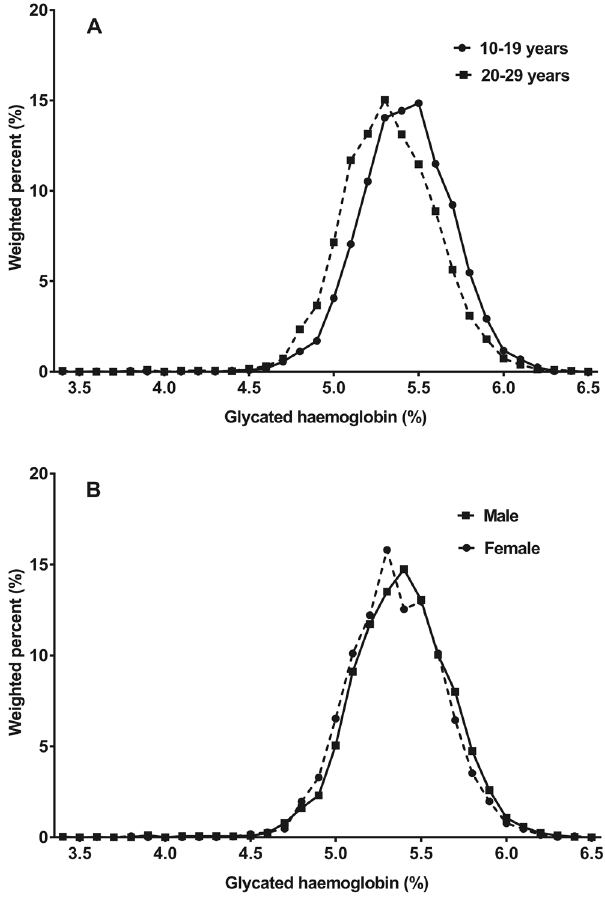
Figure 1. Distribution of glycated haemoglobin (HbA1c) by age group ( A ) and sex ( B